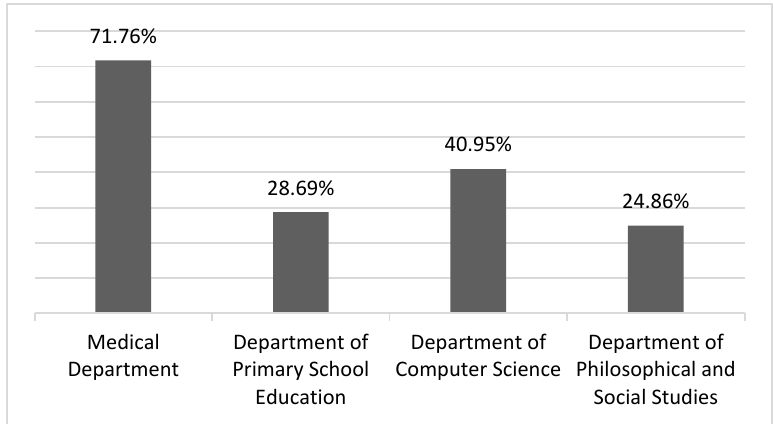
Figure 2. Percentage of students with a mother who is a higher education graduate or has postgraduate studies by university department (University of Crete).